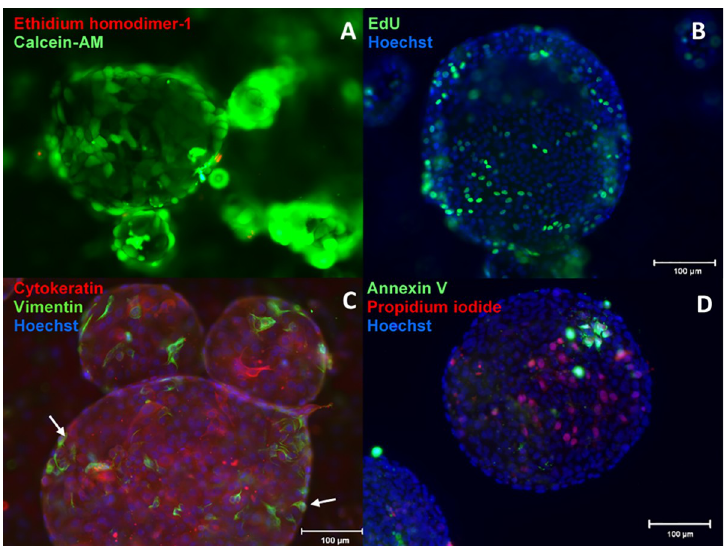
cells) show hollow, lumen-like structures. B) Proliferation assay with EdU showing cells actively synthesizing DNA and proliferating within a spherical cell structure. C) Staining of epithelial (cytokeratin) and stromal cells (vimentin) showing primarily epithelial cells forming the 3-D endometrial cell structures with stromal cells (white arrow) lining the outer surface. D) Detection of early apoptotic nuclei (annexin V) and dead cells (propidium iodide).